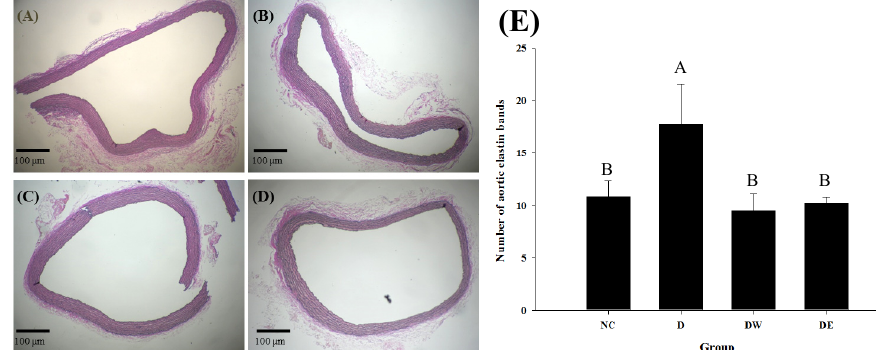
Figure 4. The effect of the extracts of TWK10 ‐ fermented soymilk on microscopic examination of aorta elastin bands number in DOCA ‐ salt hypertension induced vascular dementia rats NC ( A ), D ( B ), DW ( C ), DE ( D ) and number ( E ). Data are presented as mean ± SD ( n = 3); NC: Normal control group; D: Subcutaneous administration of DOCA ‐ salt at a dose of 20 mg/kg bw; DW: DOCA ‐ salt with administration of water extract of TWK10 ‐ fermented soymilk at a dose of 2.65 g/kg bw; DE: DOCA ‐ salt with administration of ethanol extract of TWK10 ‐ fermented soymilk at a dose of 0.09 g/kg bw. Table 7. Effects of administration of the extracts of TWK10 ‐ fermented soymilk on ACE activity in lung and kidney, angiotensin II and nitric oxide concentration in plasma of DOCA ‐ salt induced hypertension and its associated dementia rats.